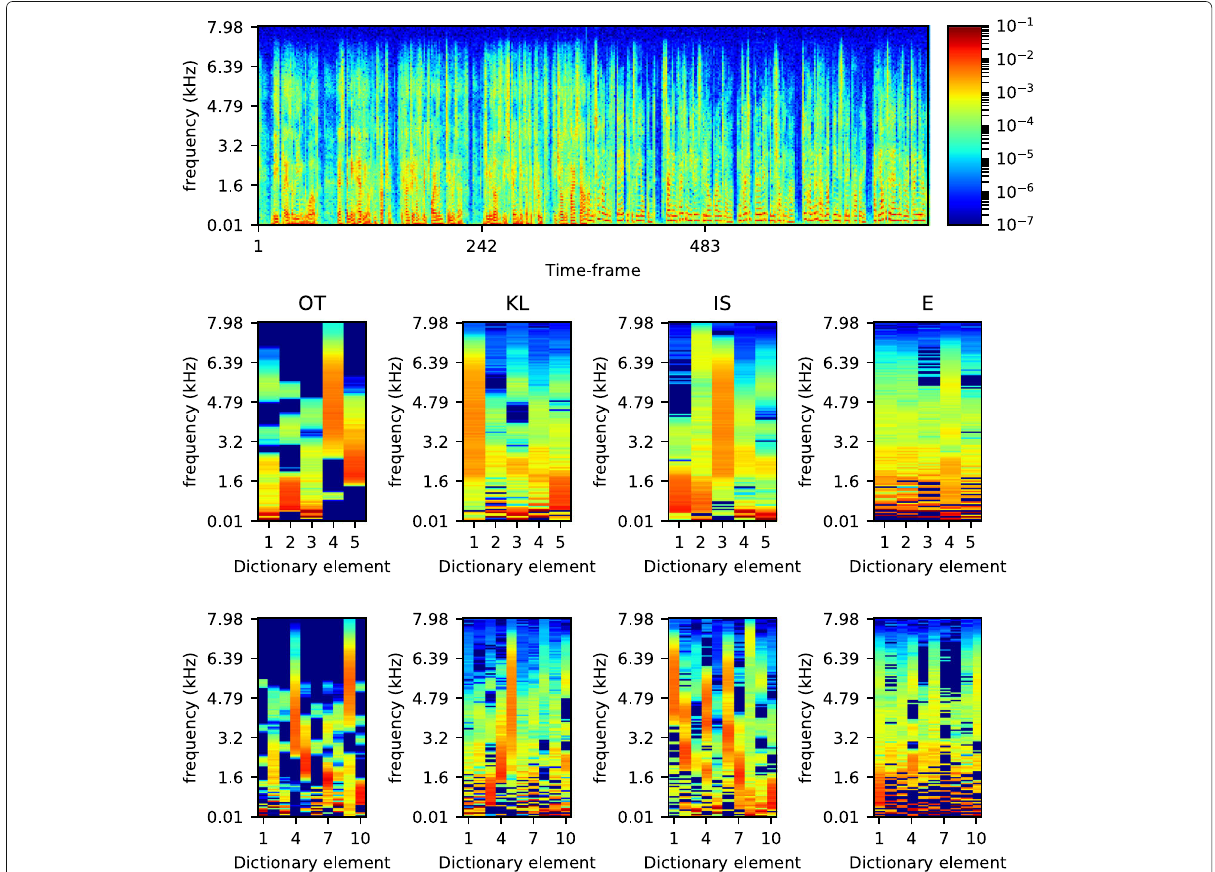
Fig. 8 Universal voice model dictionaries. Dictionaries learned for the universal model. Top row: spectrogram of the training data. Middle and bottom row: dictionaries learned with respectively 5 and 10 elements, with the optimal transport, Kullback-Leibler, Itakura-Saito, and Euclidean loss (from left to